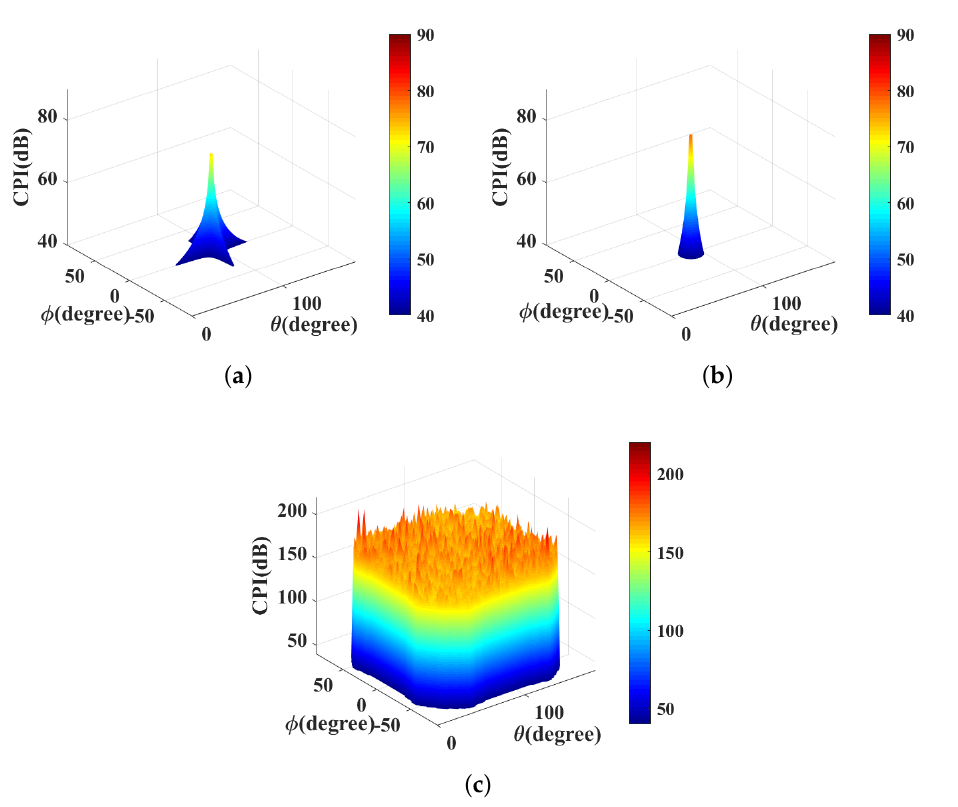
Figure 5. The available angle range of the polarized wave when the CPI is greater than 40 dB. ( a ) LP wave; ( b ) CP wave; ( c ) EP wave.